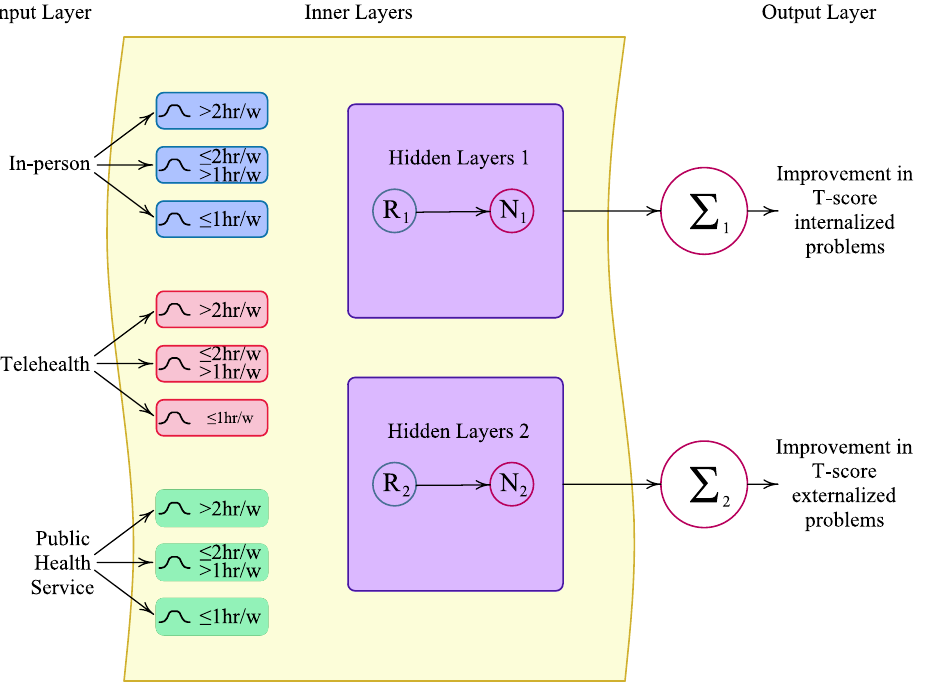
Figure 1. Designed ANFIS network to predict effects of treatment hours per week on the improvement in internalizing and externalizing problems.